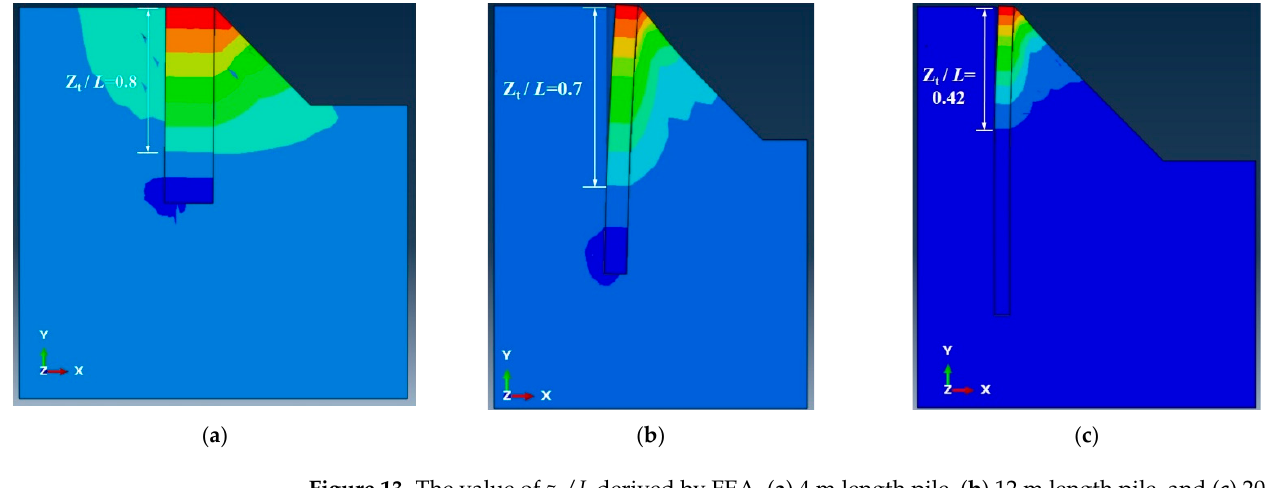
Figure 13. The value of z t / L derived by FEA. ( a ) 4 m length pile, ( b ) 12 m length pile, and ( c ) 20 m length pile.